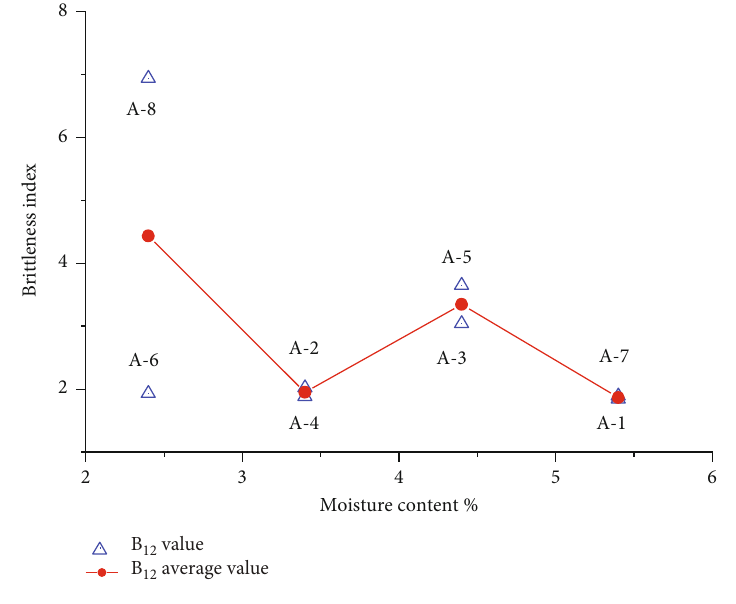
Figure 12: B under di ff erent moisture content. 12